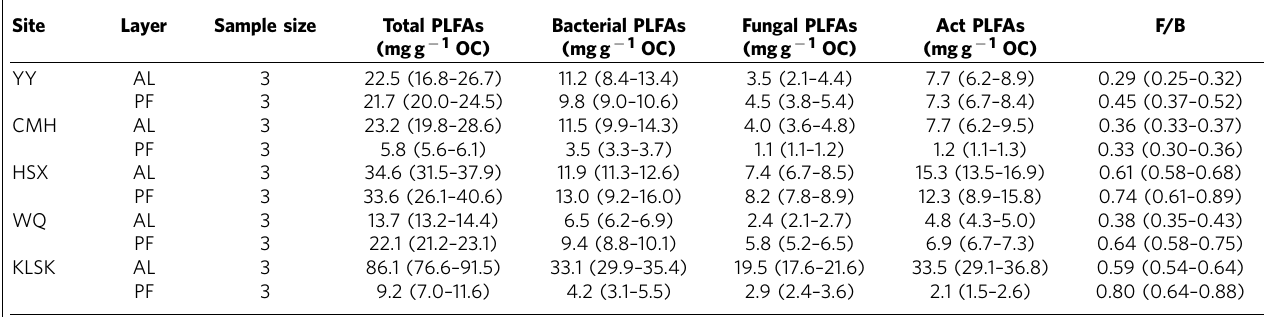
The five sites are Youyun (YY) and Changmahe (CMH) in Maqin County, Huashixia (HSX) in Maduo County, Wenquan (WQ) in Xinghai County and Kunlunshankou (KLSK) in Geermu. Act, actinomycete; F/B, the ratio of fungal PLFAs to bacterial PLFAs. The interquartile range is presented in